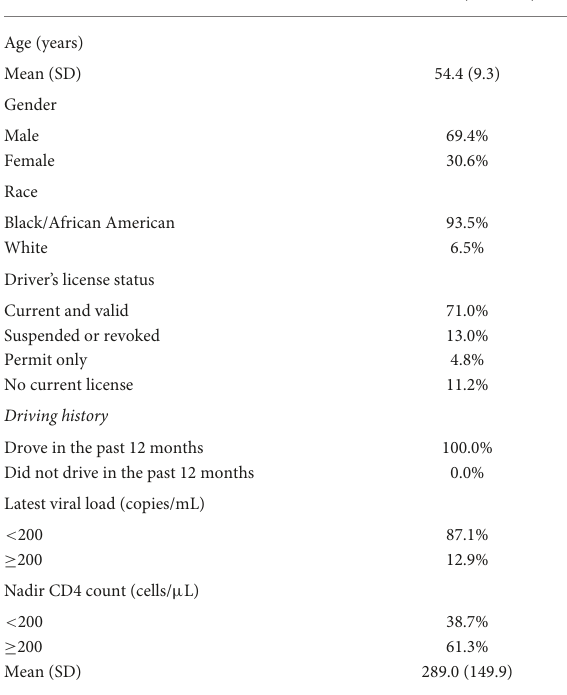
TABLE 3 Demographic and clinical characteristics of the final study